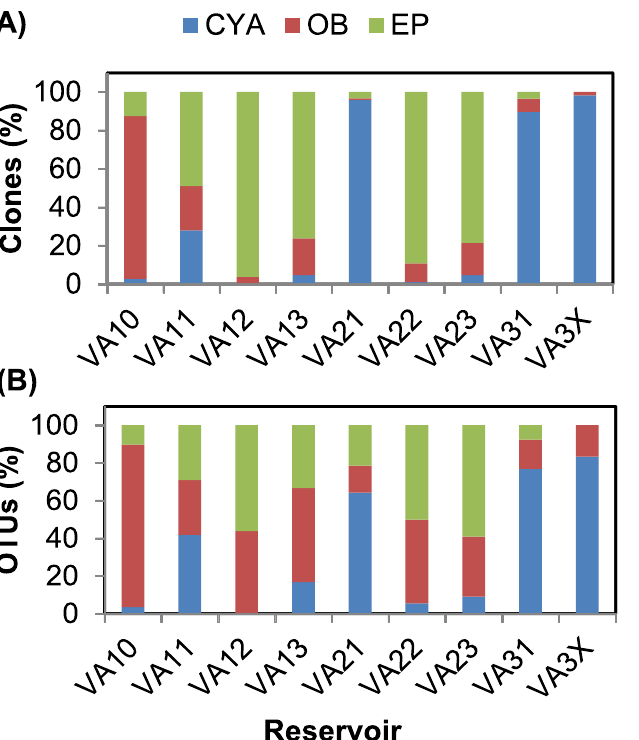
Fig 4. Microbial community composition in eight reservoirsand one adjacent stream.A. Evennessor percentage of clones within groupsin each reservoir. B. Richness or the percentage of OTUs within groupsin each reservoir. CYA = cyanobacteria, EP = eukaryoticphytoplankton, and OB = other bacteria.